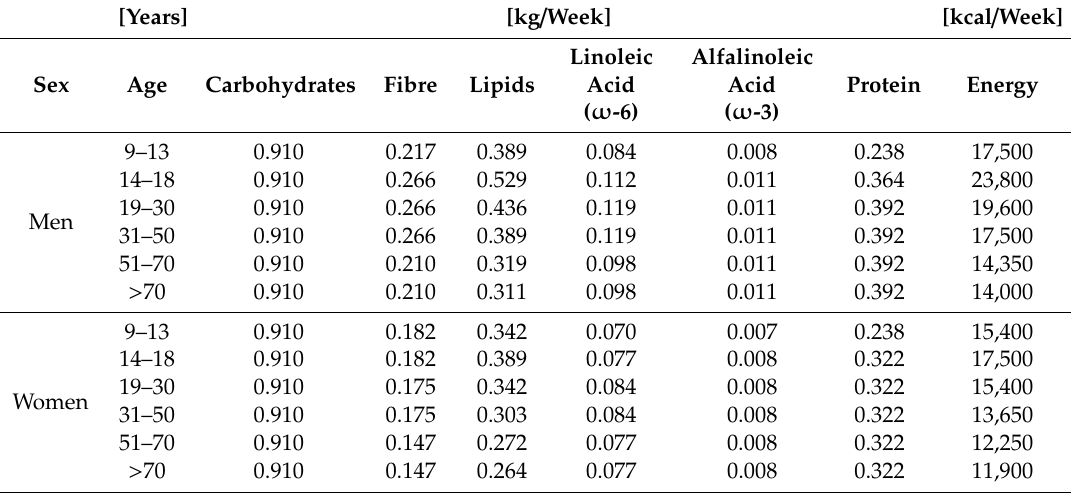
Table 1. Macronutritional and energy